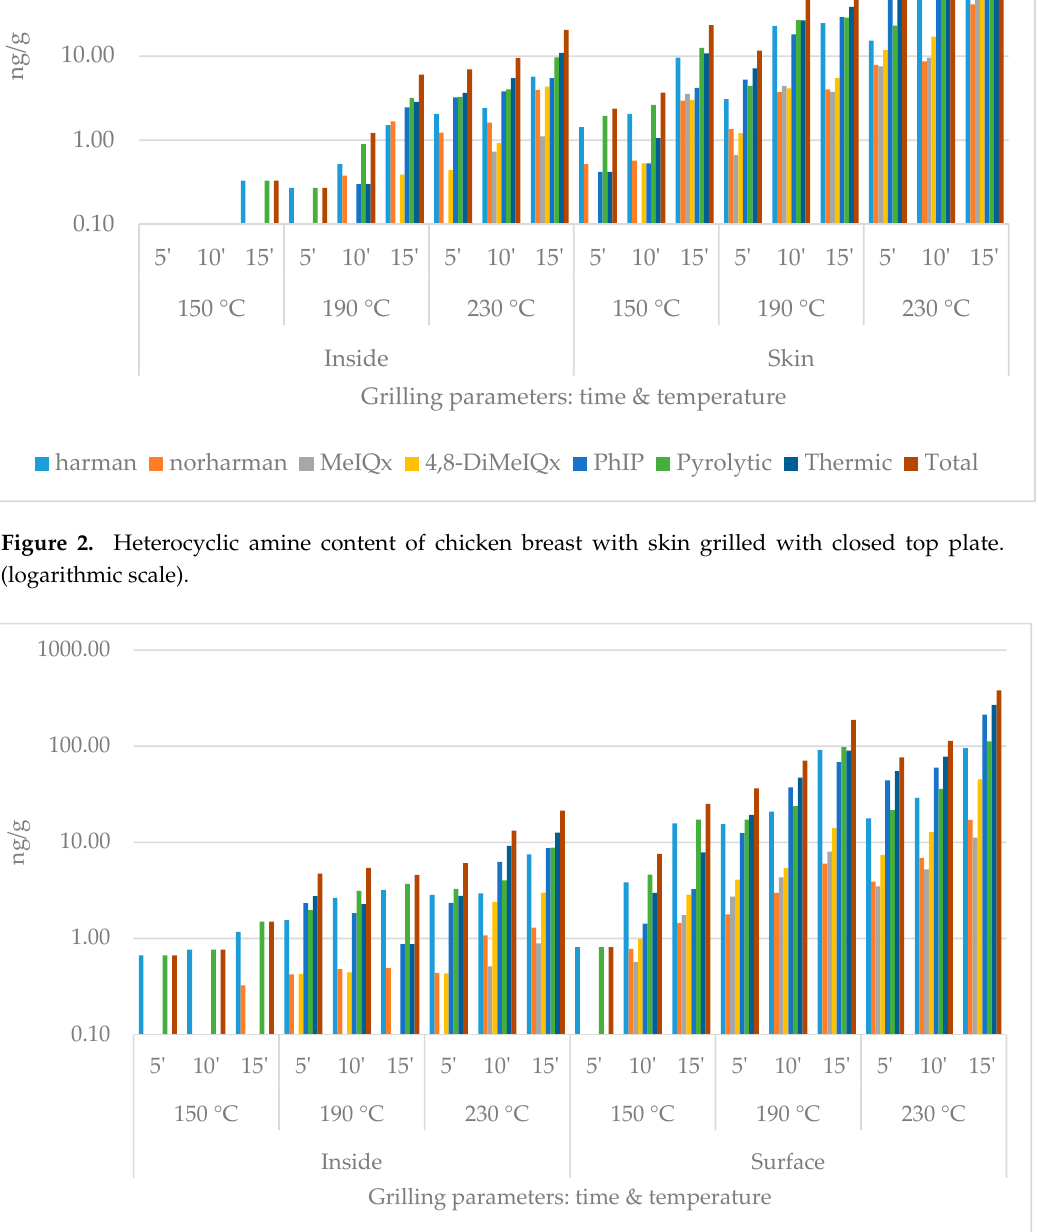
6 of 16 Figure 1. Heterocyclic amine content of chicken breast without skin grilled with closed top plate.